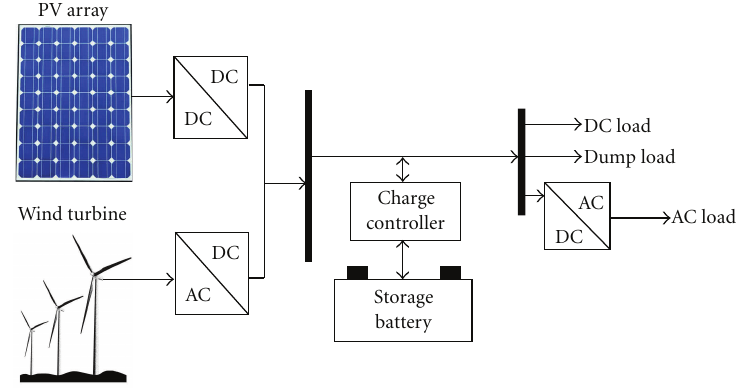
Figure 10: Typical components of a hybrid PV/wind System.